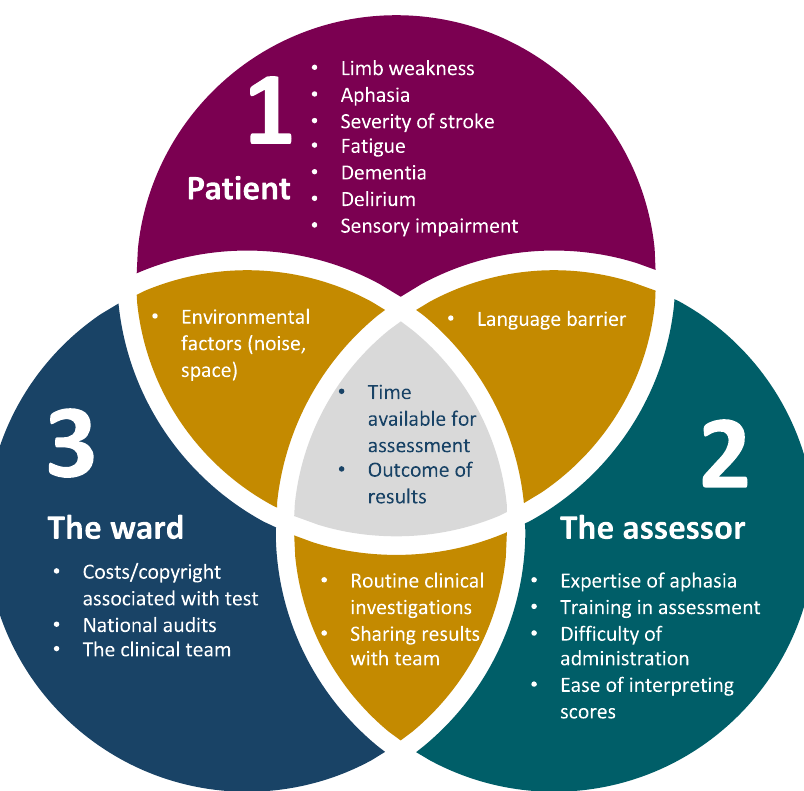
Figure 2. Factors a ff ecting feasibility of cognitive assessment in acute stroke. Factors listed are Figure 2. Factors affecting feasibility of cognitive assessment in acute stroke. Factors listed are illustrative but not exhaustive. illustrative but not exhaustive .